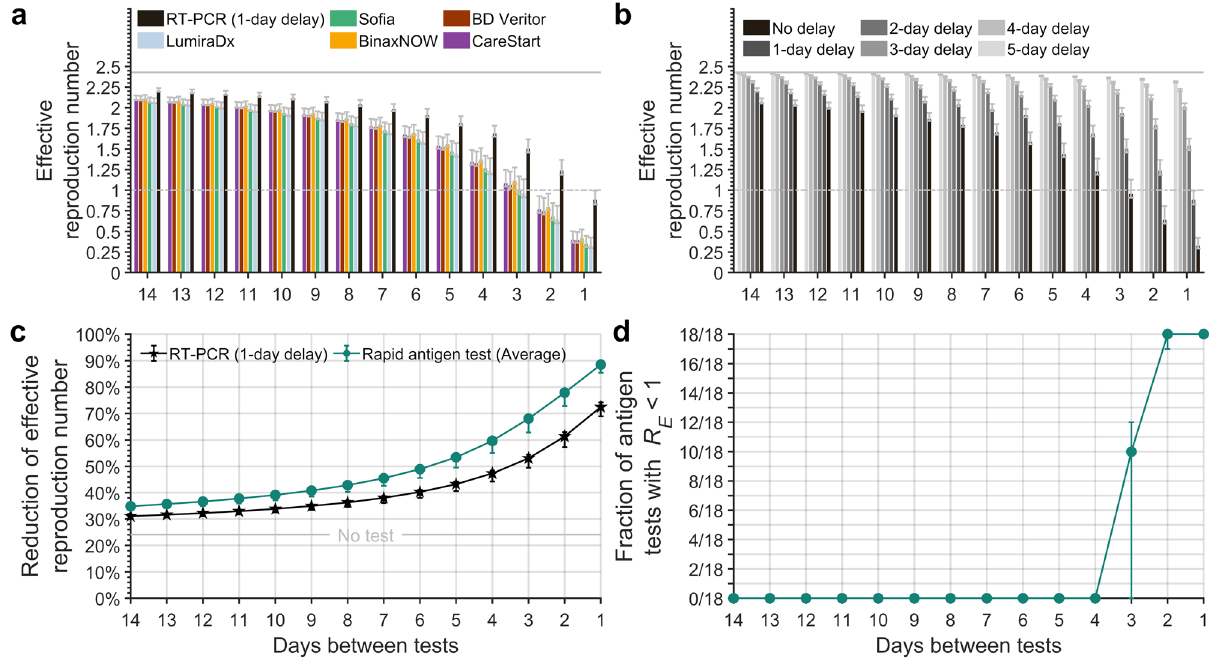
Fig. 3 Effective reproduction number in the context of different frequencies of serial testing. Specifying 35.1% of infections as asymptomatic, a 24-h delay in obtaining RT-PCR test results, no delay in receiving rapid antigen test results, an incubation period of 4.4 days, self-isolation upon symptom onset, and a RT-PCR diagnostic sensitivity curve informed by data from Hellewell et al. 11 , a the expected effective reproduction number with serial testing using an RT-PCR test (black) and the rapid antigen tests LumiraDx (light-blue); So fi a (green); BinaxNOW (yellow); BD Veritor (dark-red); and CareStart (purple); and b for serial testing every day to every 14 days with a zero- to fi ve-day delay (black to light gray) in obtaining the results for an RT-PCR test and isolation of positives in comparison to no testing (solid gray line). c The mean reduction of the effective reproduction number (with no self-isolation upon symptom onset) of the 18 RA tests (green circles), of RT-PCR with a one-day delay (black stars), and no test (gray line), with self-isolation upon symptom onset. d The fraction of rapid antigen tests of the 18 tests that had an effective reproduction number ( R E ) below one for testing frequencies ranging from every day to every 14 days and isolating positives. The whiskers denote the 95% credible interval based on 1,000 samples of an RT-PCR diagnostic sensitivity curve and rapid antigen percent positive agreement curve.